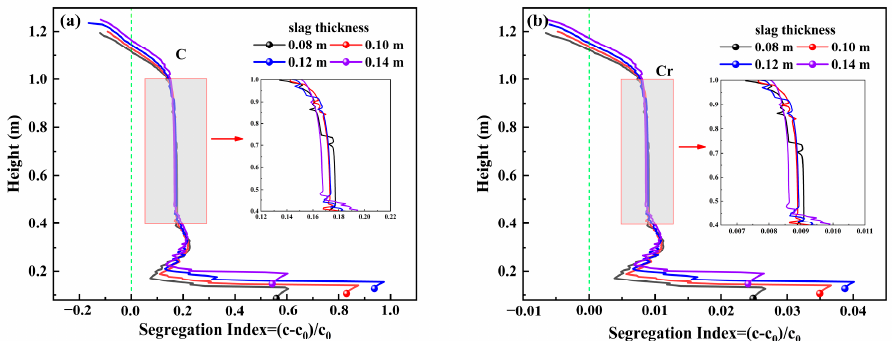
Figure 23. Change of C ( a ) and Cr ( b ) centerline segregation index with varying slag thickness. As discussed above, it can be found the change of melting ratio in the study range causes the most serious impact on the ESR solidification process. Deep molten pool and coarse structures can be viewed in the case of high melting rate. Increase of filling ratio increases the mushy zone width and thus decreases the temperature gradient, meanwhile LST, SDAS and segregation receive a slight rise. An inflection can be observed with respect to the molten pool depth and mushy zone width when increasing slag thickness. LST, SDAS, segregation of C and Cr approach their maximum when the slag thickness increases to 0.12 m. To sum up, a low melting rate less than 120 kg/h, a filling ratio of about 0.23 – 0.33 and a slag thickness of 0.08 – 0.10 m are suggested for ESR process of high carbon stainless steels in this study through synthetical consideration with the whole ESR